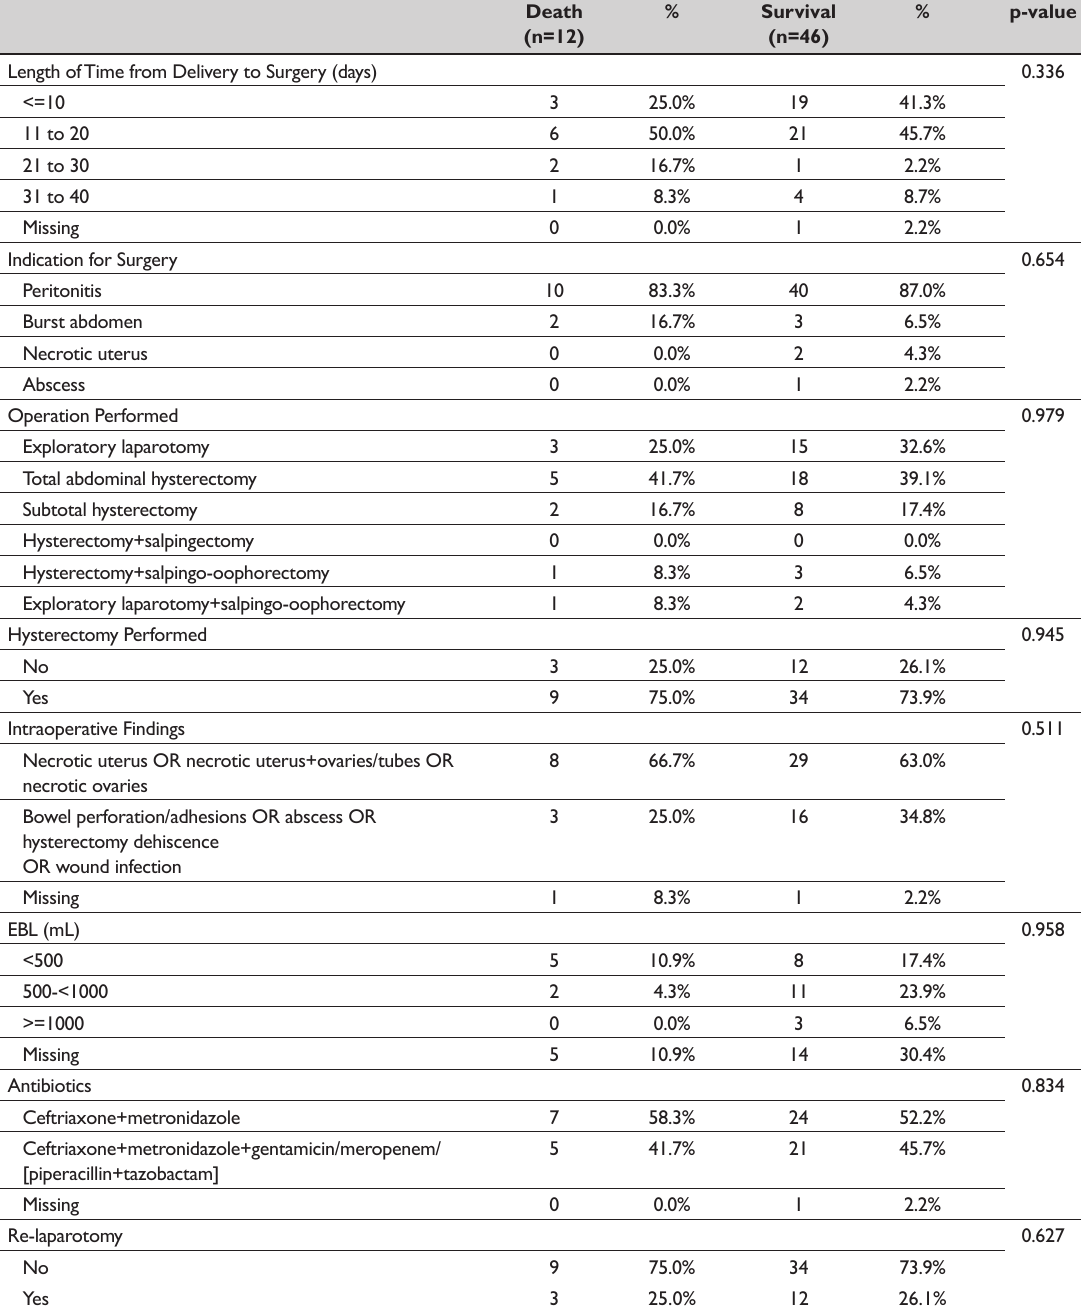
Table 2: Surgical findings: death vs. survival